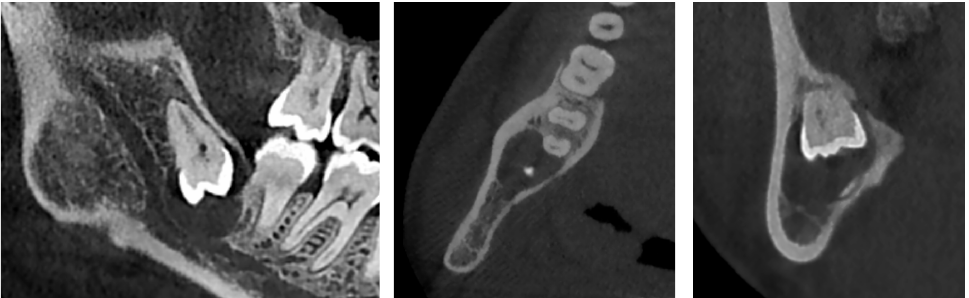
Figure 6. CBCT X-ray of case #2.